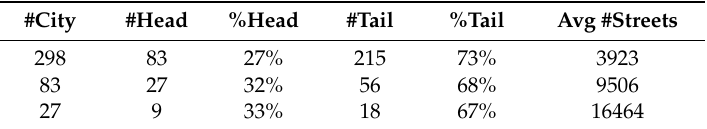
Figure 5. Power-law distributions of #segments and #streets per city (note: # = number). Table 2. Head / tail breaks statistics for the number of natural streets for 298 cities.